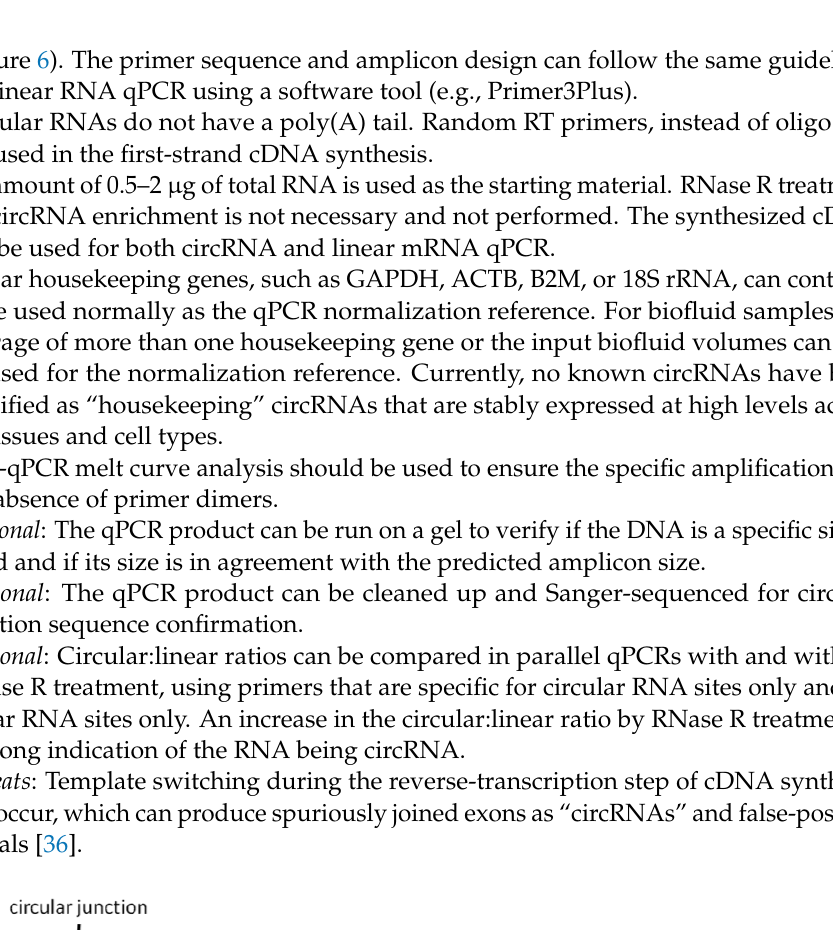
Table 6. Differentially expressed circRNAs from circRNA microarray profiling, analyzed for miRNA sponge functions (published in years 2020 – 2022).